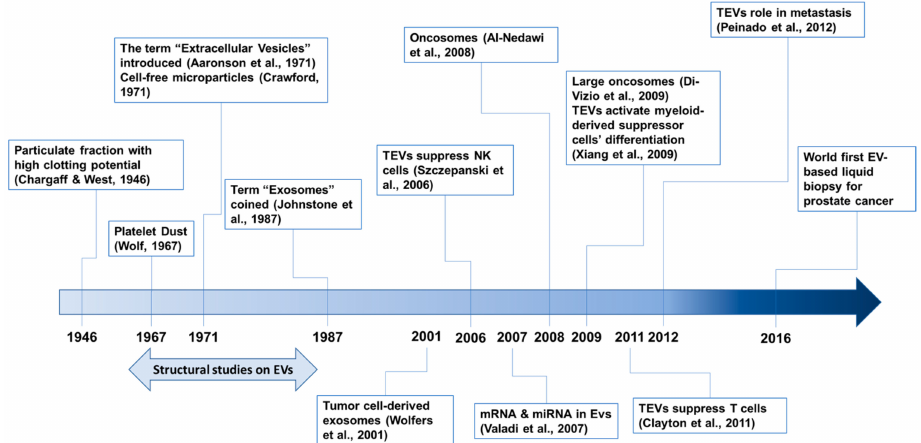
Figure 1. Timeline of selected events in the field of tumor-derived EV (TEV) research.